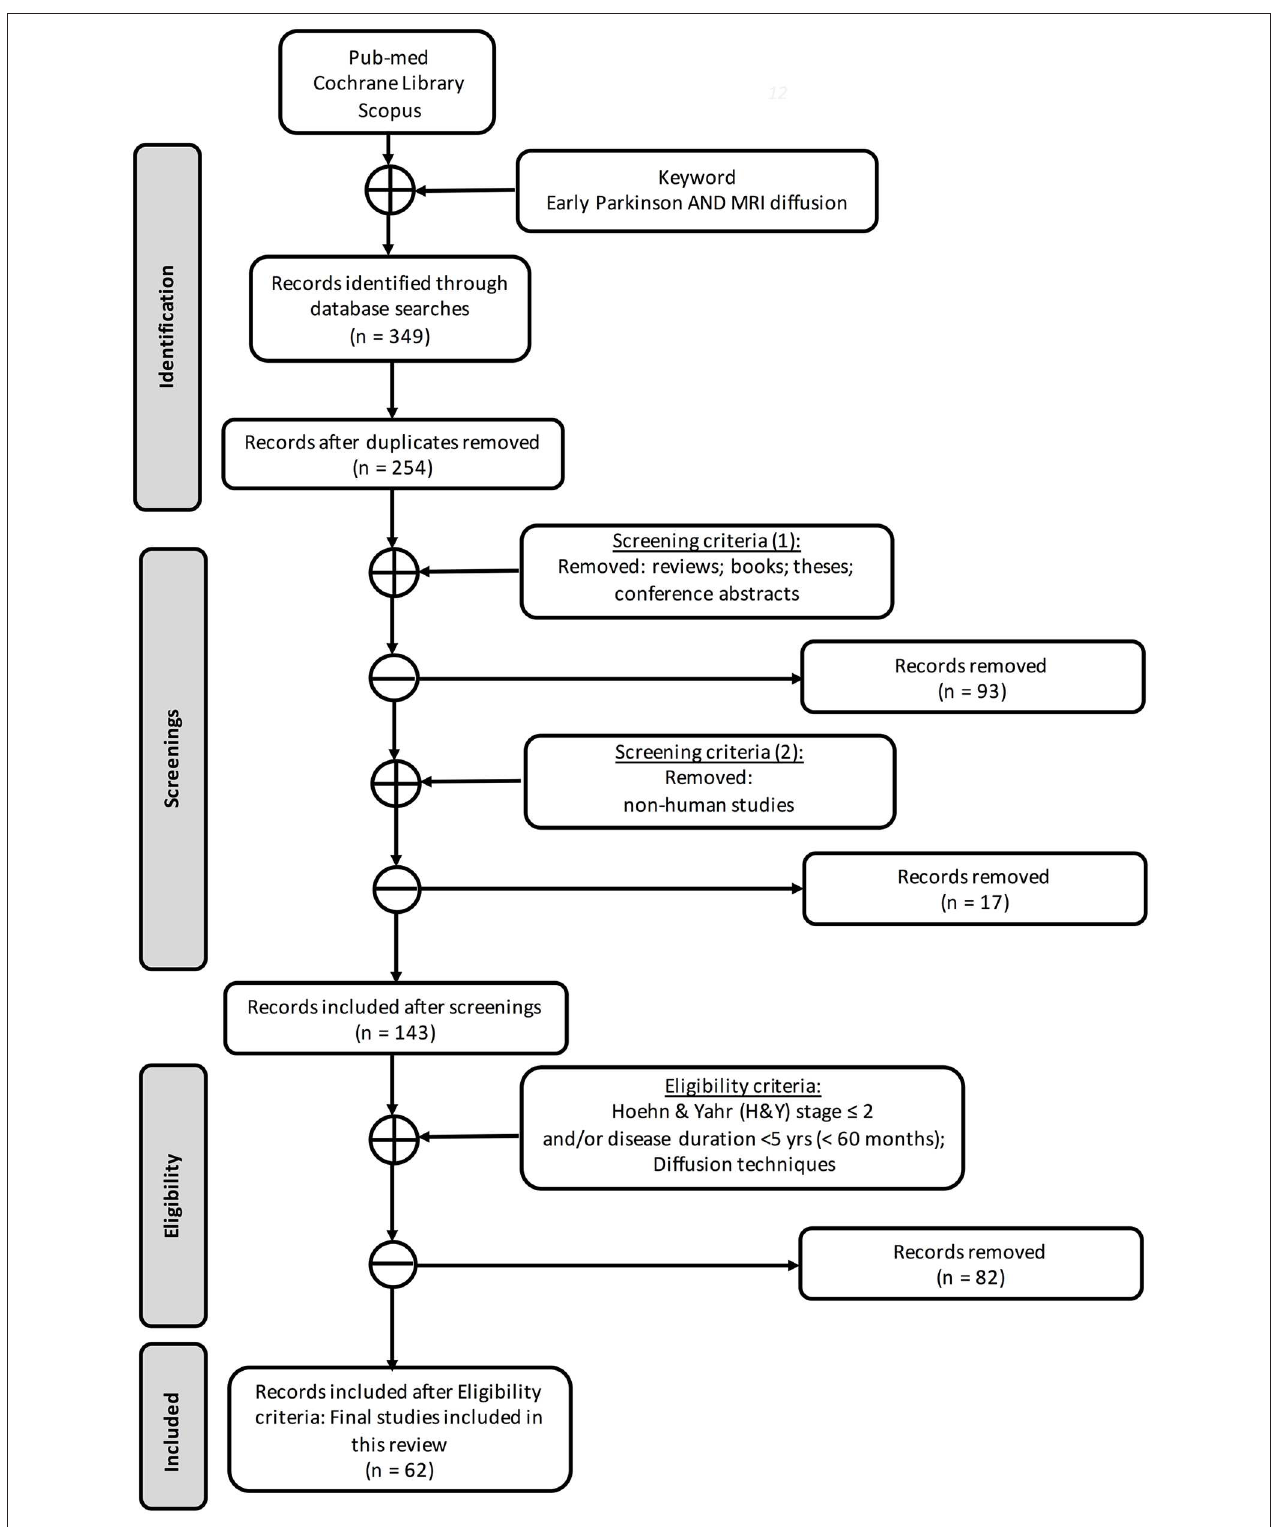
FIGURE 1 | Search strategy based on PRISMA flow